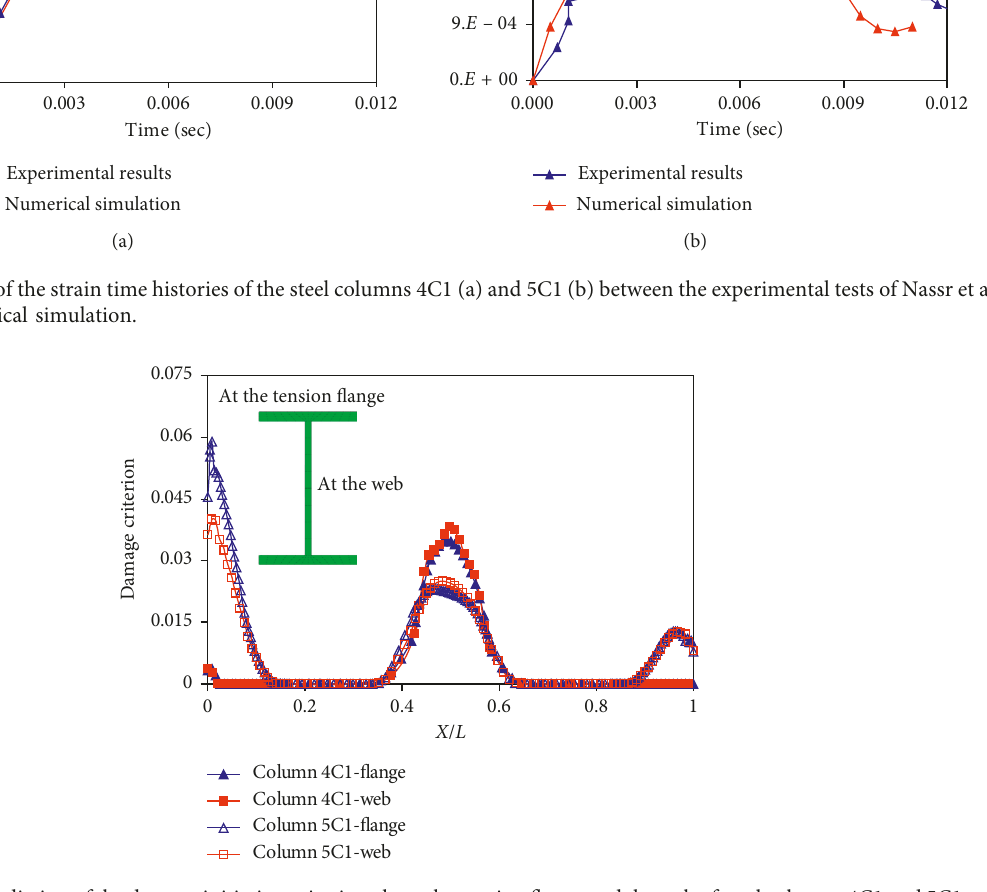
Figure 6: Numerical prediction of the damage initiation criterion along the tension flange and the web of steel columns 4C1 and 5C1 used in Nassr et al.’s tests [4].